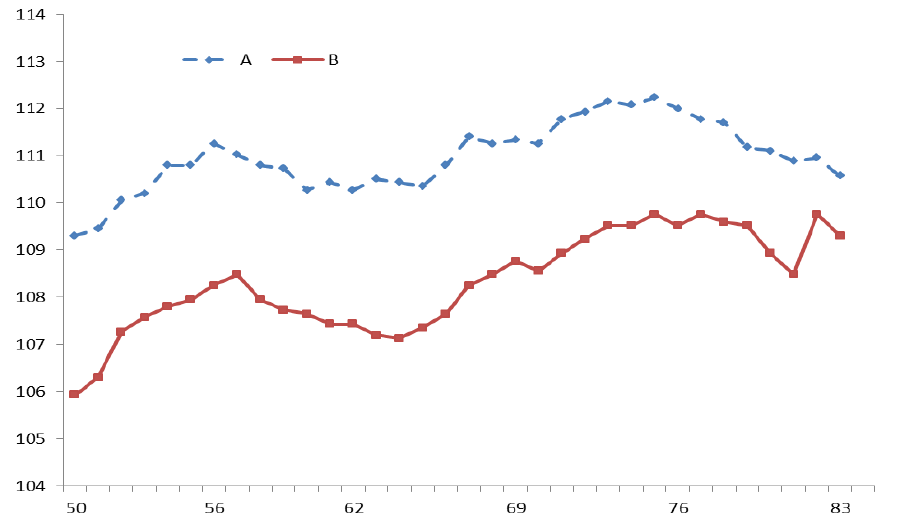
Figure 3. Intelligence test scores (IQ units) by conscript birth year and sibship size. (Series A: ≤ 3 sibs, series B: ≥ 4